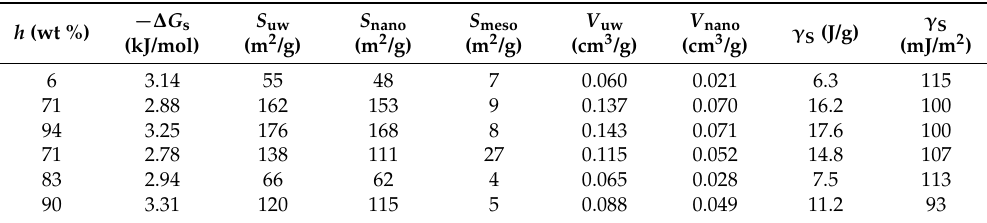
Table 5. Characteristics of water bound to MCC/A-300 (1–8 samples) or MCC/TiO 2 (9–13 samples) at different water contents ( h ) [13].